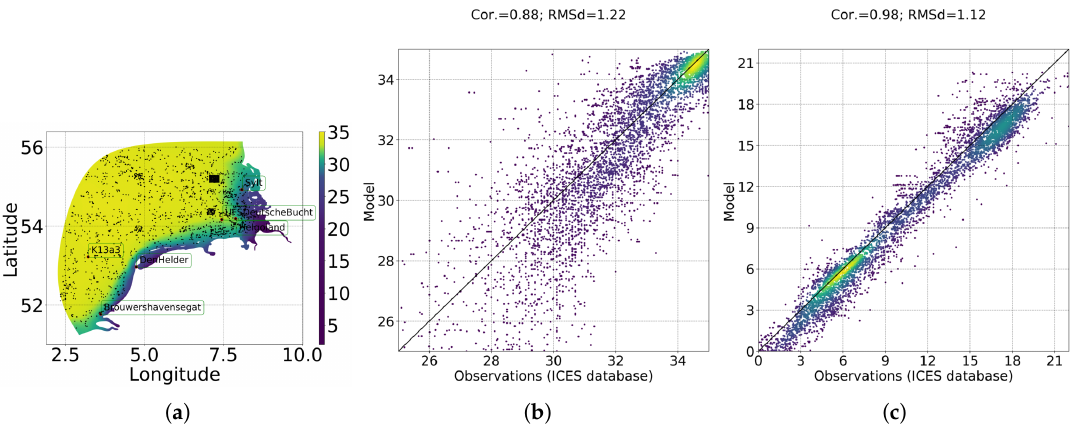
Figure 4. ( a ) Mean sea surface salinity for the years 2010–2014. The black dots indicate positions of data from the ICES database; black-with-red circles indicate positions of stations giving temperature and salinity time series with the corresponding names. ( b , c ) Sea surface salinity and temperature from FESOM-C (y-axis) compared one-to-one with values from the ICES database (x-axis) with corresponding correlation coefficients (Cor.) and root mean square difference